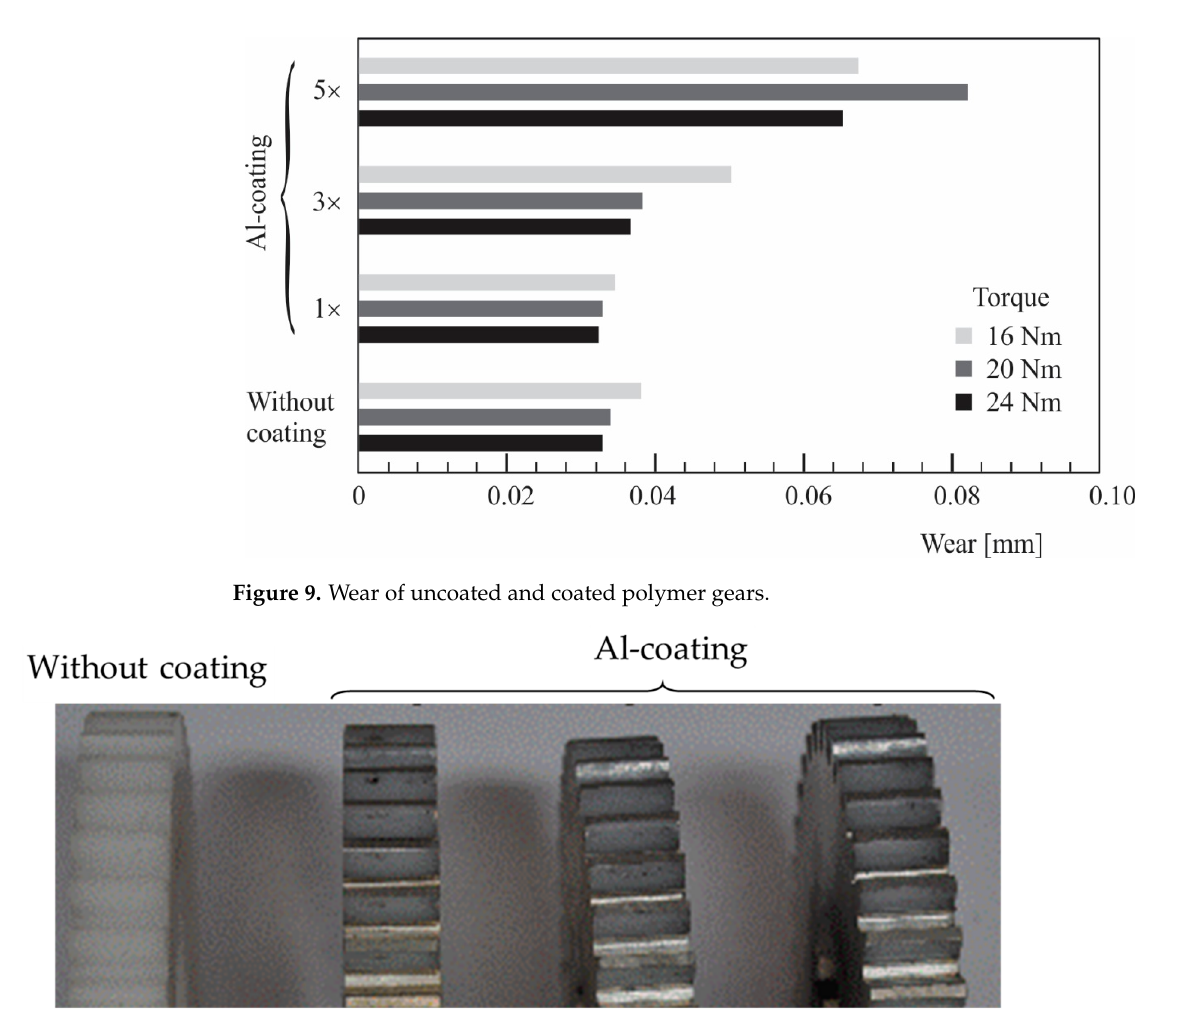
Figure 9. Wear of uncoated and coated polymer gears.